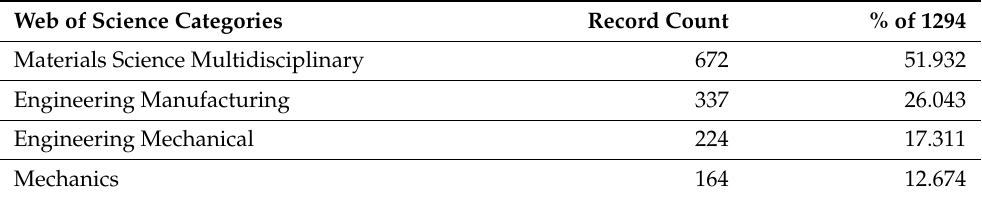
Figure 10. Visualisation treemap chart of different disciplines that published articles on “additive manufacturing on lattice structure” research (data retrieved from the WoS database on 20 June 2022). Table 2. Data on publication subjects on “additive manufacturing on lattice structure” from WoS.